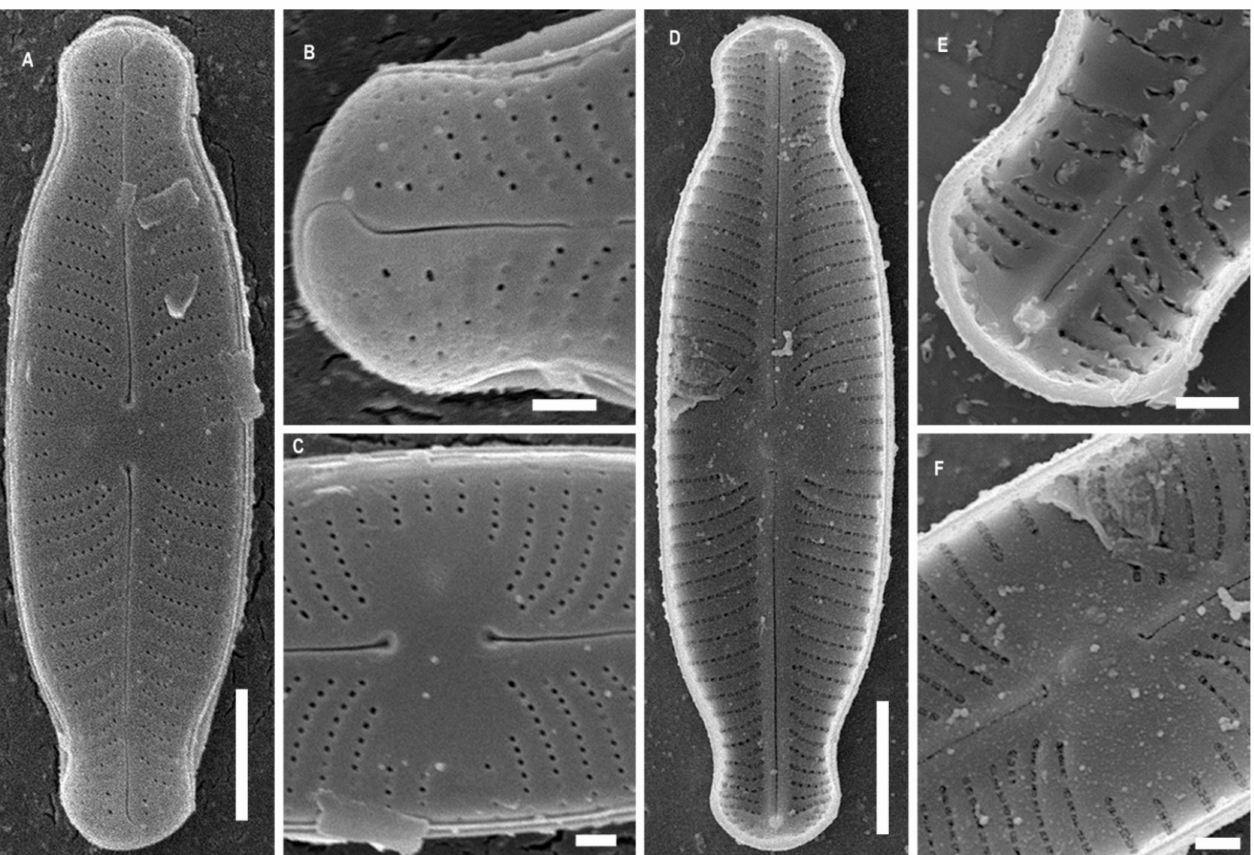
Figure 3. Placoneis baikaloelginensis Kezlya, Glushchenko, Kulikovskiy & Kociolek sp. nov. Strain B 703, sample No. 01493. Scanning electron microscopy: ( A – C ) External views. ( D – F ) Internal views. ( A , D ) The whole valve. ( C , F ) Central area details. ( B , E ) Valves ends. Scale bars ( A , D ) = 5 µ m; ( B , C , E , F ) = 1 µ